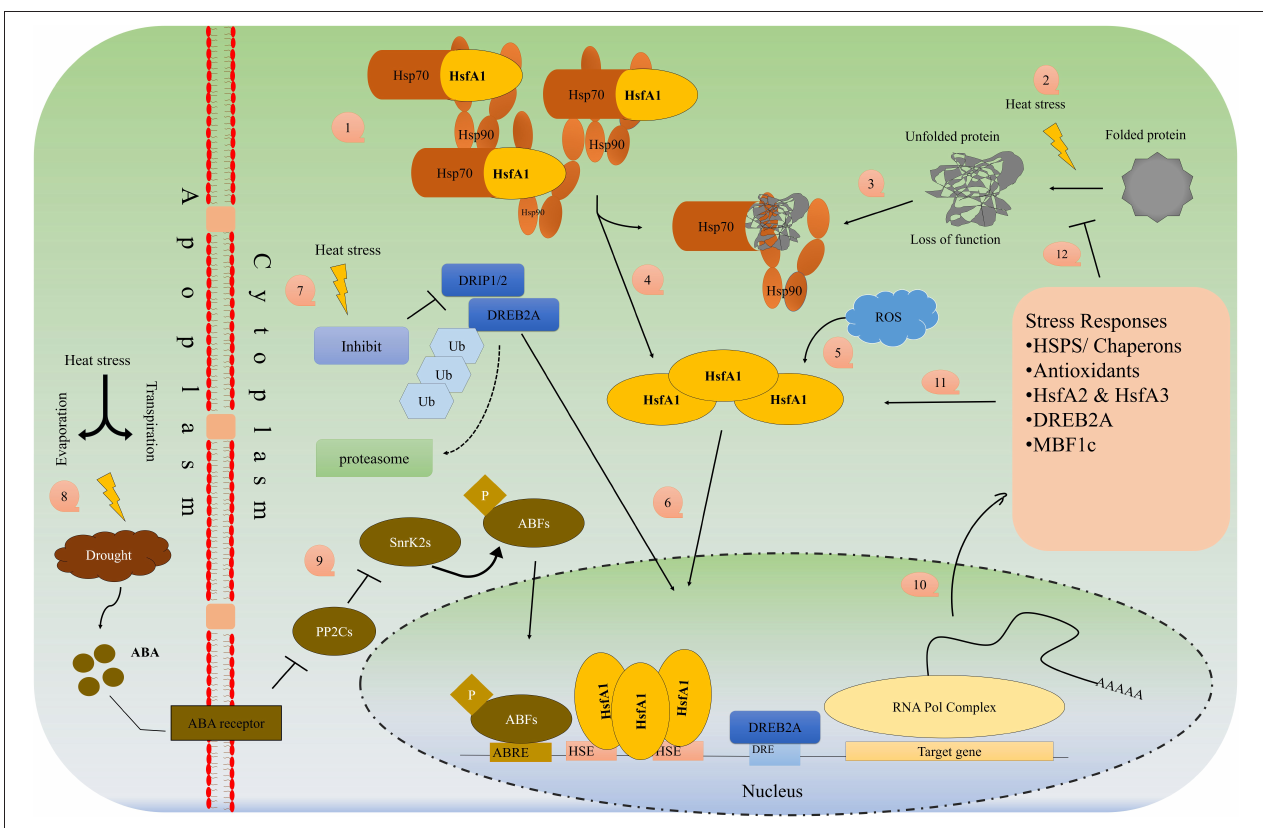
FIGURE 3 | Schematic overview of HSP/HSF’s pathway activation under heat/drought stress.